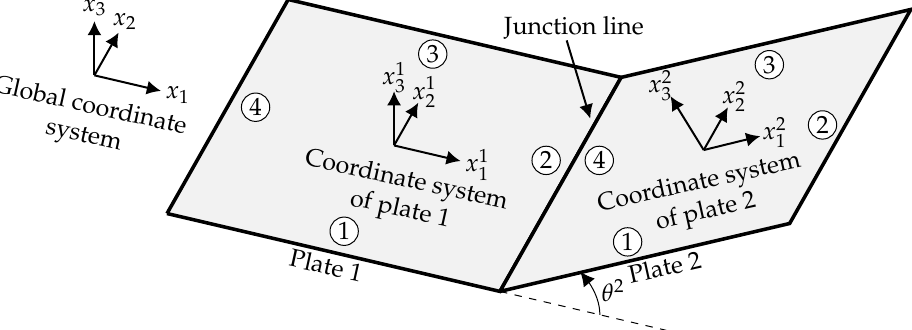
Figure 3. An assembled plate structure consisting of two plates joined together along a junction line. Each plate has its own local coordinate system ( x i